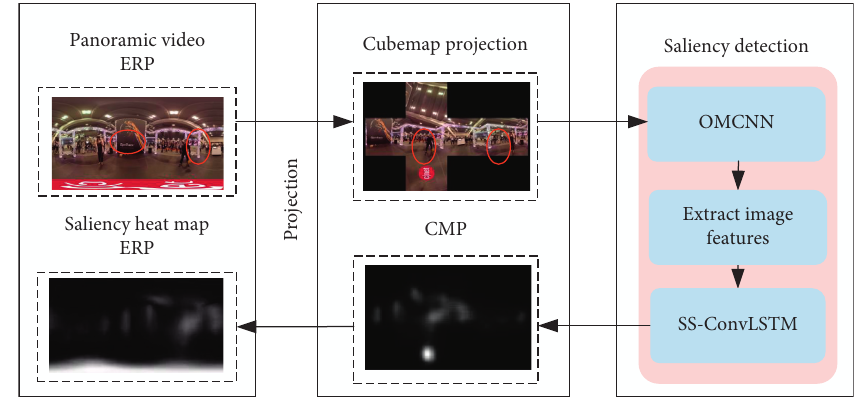
Figure 3: 360-degree video saliency detection.